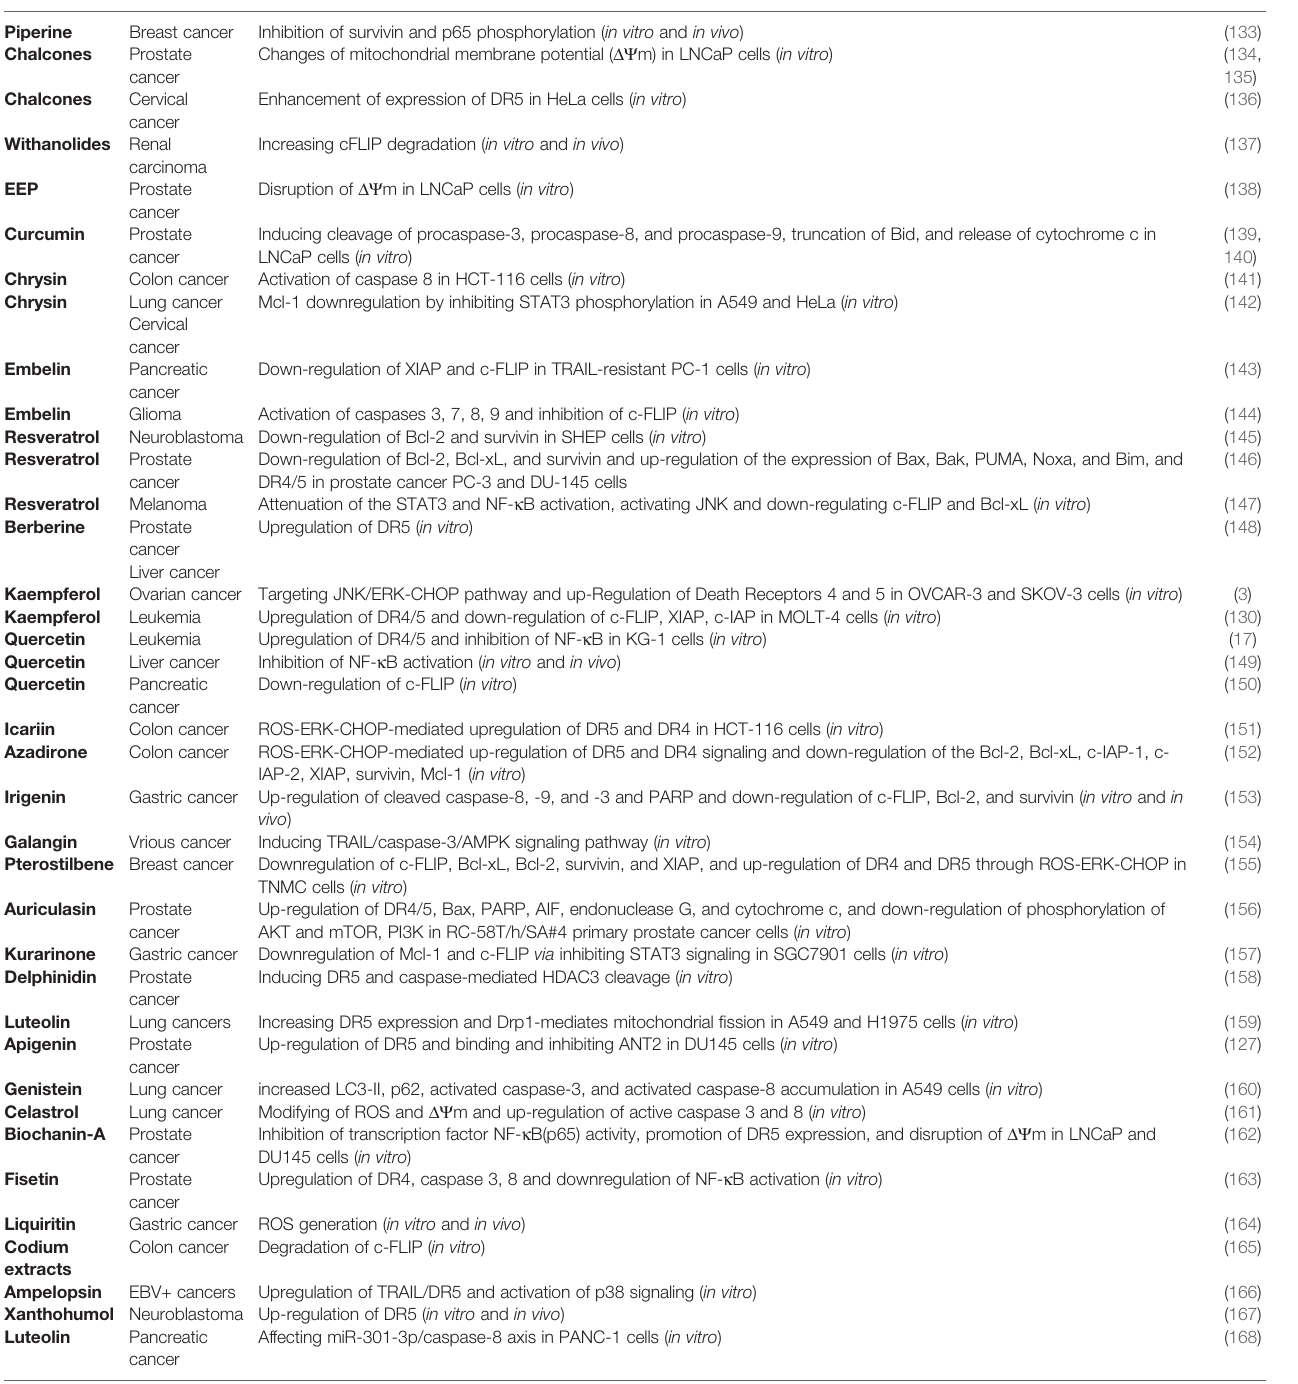
TABLE 2 | Combination therapy with natural products and TRAIL for improving TRAIL-mediated apoptosis in TRAIL-resistance cells.